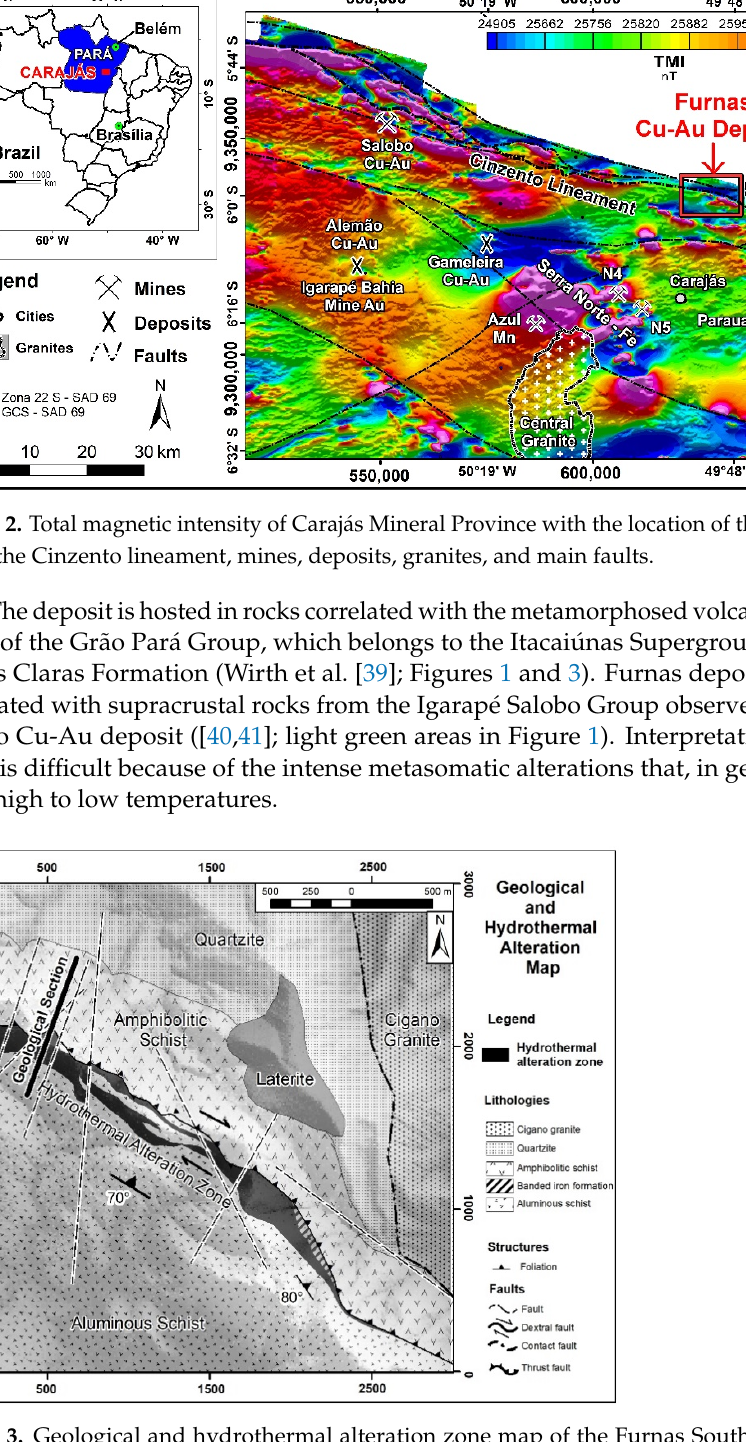
Figure 3. Geological and hydrothermal alteration zone map of the Furnas Southeast deposit; the location of the geological section shown in Figure 4 is indicated by the solid black line.